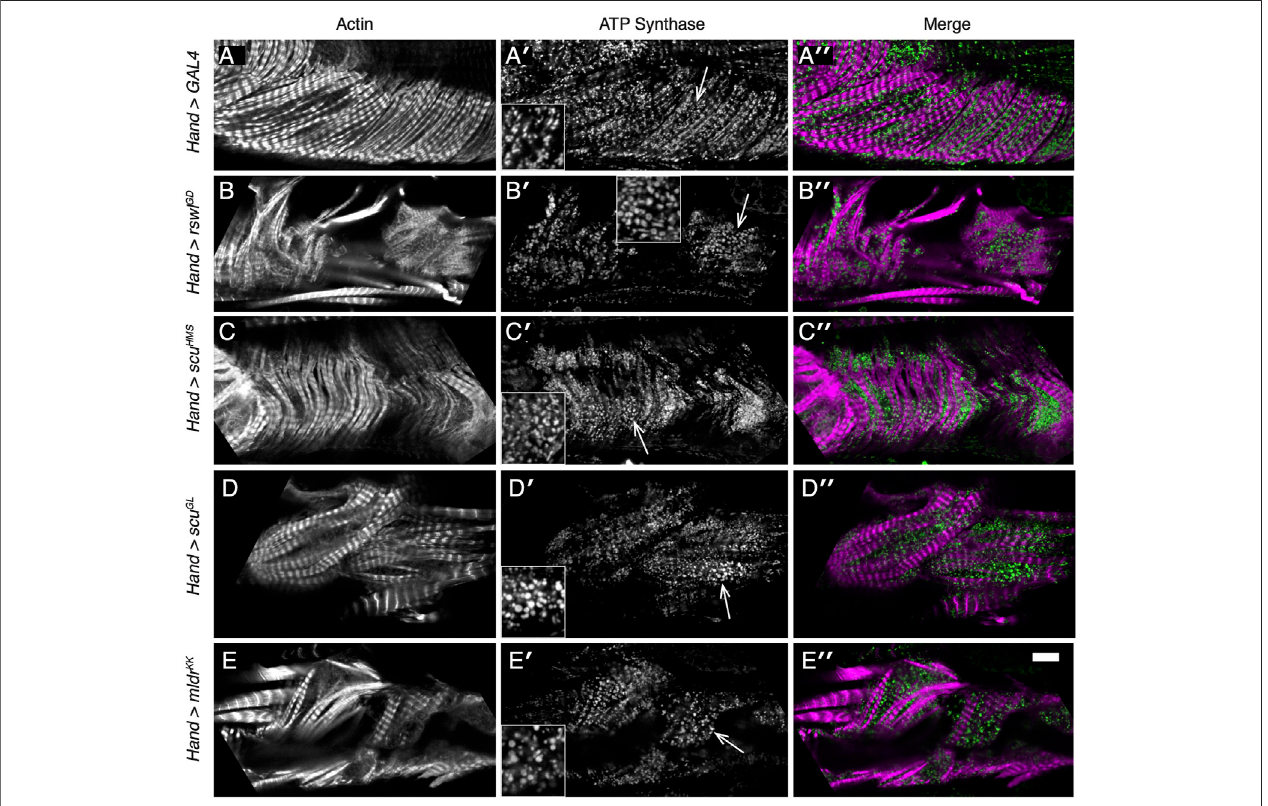
FIGURE 5 | Reduction of mtRNAse P subunits in the adult heart disrupts myo fi bril organization and mitochondrial morphology. (A – E 99 ) Confocal microscopy micrographs of hearts from adult female fl ies grown at 29 ° C. (A – A 99 ) Mitochondria [ (A 9 ) , green] in control Hand > GAL4 RNAi hearts form a lattice between the regularly spaced myo fi brils [ (A 9 ) , magenta]. (B-E 99 ) Labeled hearts from fl ies expressing mtRNase P RNAi using Hand GAL4 indicates the myo fi bril pattern is disrupted [ (B – E) , white, (B 99 – E 99 ) , magenta]. Mitochondrial morphology is also different compared to control with many mitochondria larger than control [ (B 9 – E 9 ) , arrows vs. (A 9 ) ]. The area of the inset is indicated by the arrow. Actin = white, (A – E) , magenta (A 99 – E 99 ) . anti-ATP synthase antibody = white (A 9 – E 9 ) , magenta (A 99 – E 99 ) . Scale bar = 10 μ m in E ″ for (A – E 99 ) and 5 μ m for insets.